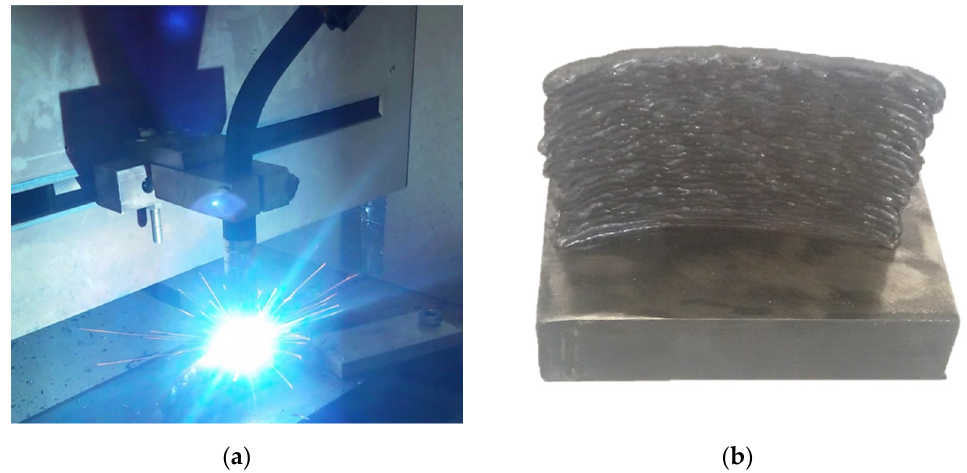
Figure 2. Wire-arc-additive-manufacturing (WAAM) deposition ( a ), airfoil after the deposition ( b ).